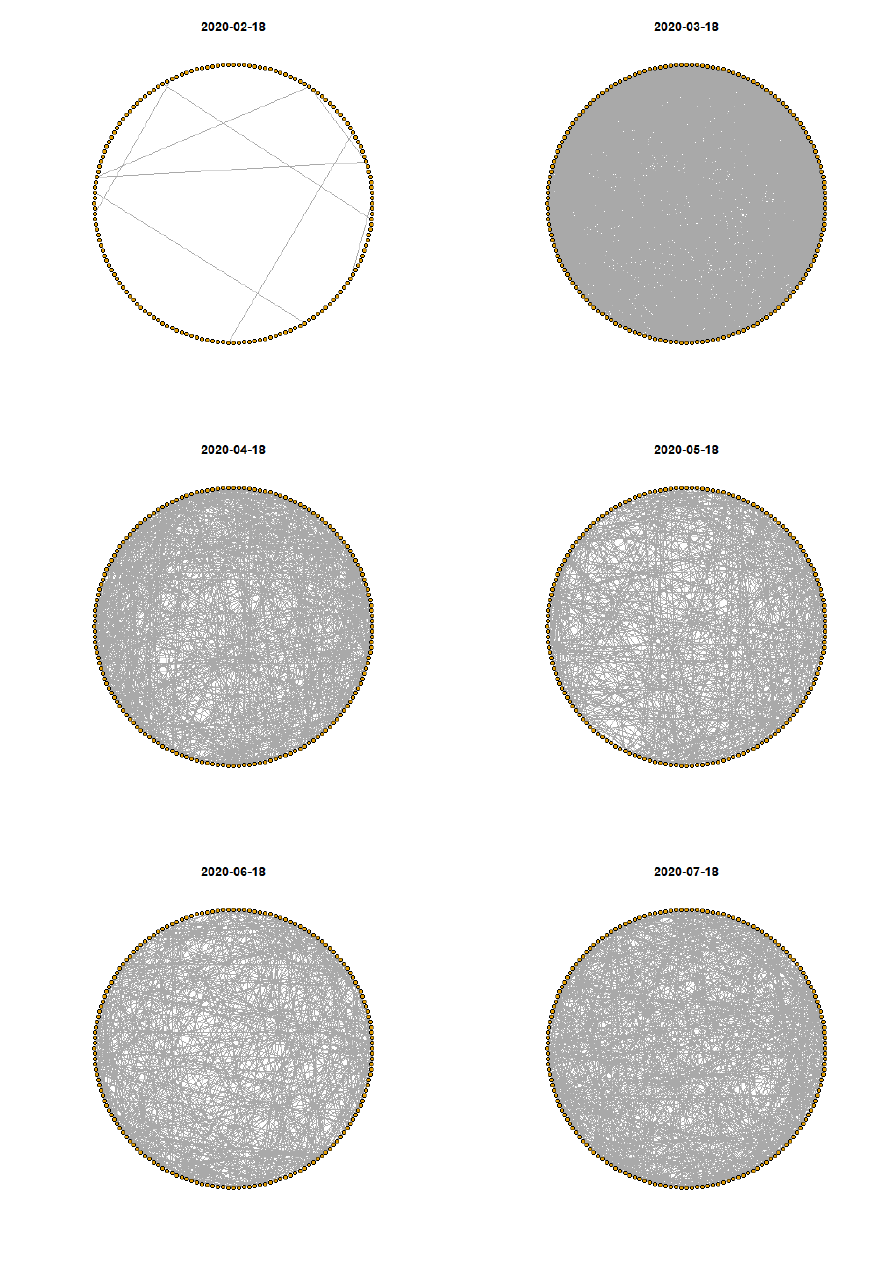
Figure 2. Snapshots of the pandemic network on the eighteenth day of each month from February